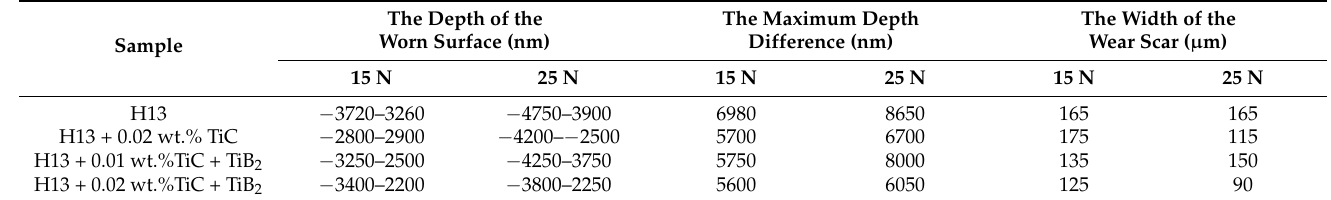
Figure 8. White light interference of worn surface of H13 steels without and with nanoparticles under sandpaper with abrasive particle size of 28 µ m and different loads: ( a 1 – d 3 ) 15 N and ( e 1 – h 3 ) 25 N. Table 4. White light interference results for different steels without and with nanoparticles under the loads of 15 N and 25